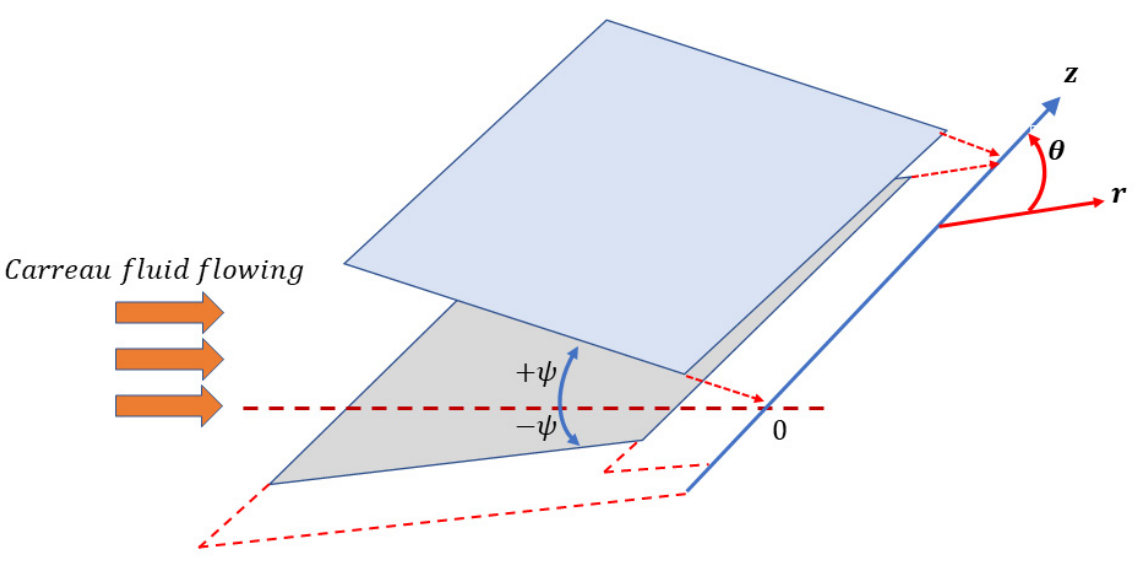
Figure 1. Geometrical configuration of the flow.